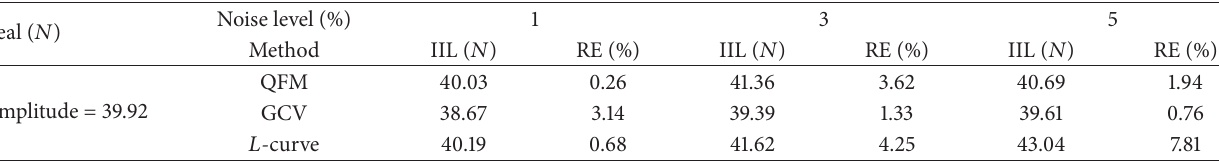
Table 2: Relative results of identified impact load of SISO system.